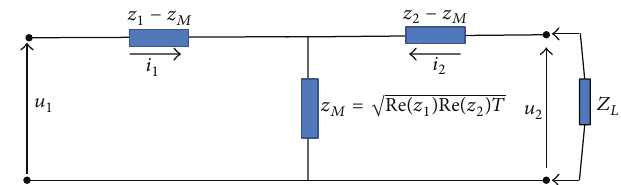
Figure 1: Equivalent scheme of WPT